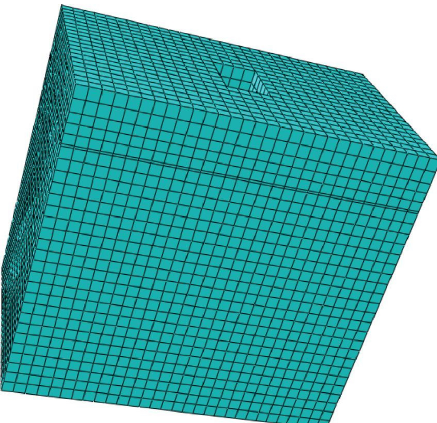
Figure 5: Schematic of the fnite element mesh.